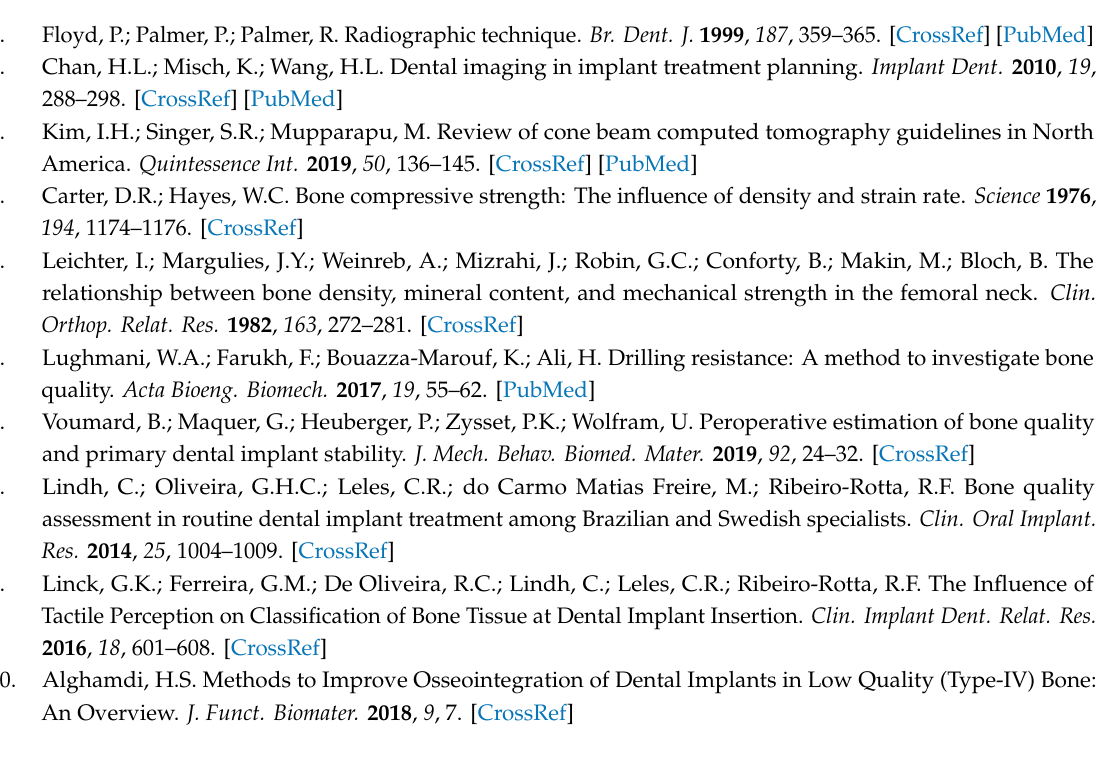
trabecular bovine tibia plateau sampling with the corresponding inclusion / exclusion criteria, Figure S3: Yucatan minipig sampling with the corresponding inclusion / exclusion criteria, Figure S4. Human data sampling with the corresponding inclusion / exclusion criteria. Table S1. Summary of in vitro bone surrogate material. Table S2. Summary of in-vitro bovine trabecular bone material. Table S3. Summary of in vivo minipig study material. Table S4. Summary of in vivo handling surveys’ material. Table S5: Mean ± Standard deviation for the maximum OS1 torques per length per density in bone surrogates. Table S6. Regression analysis of in vitro data: correlation between site preparation torque and density. Table S7. Mean ± Standard deviation for the maximum implantation torques per length per density in bone surrogates. Table S8. Regression analysis of in vitro data: correlation between implant insertion torque and site preparation torque. Table S9. Regression analysis of in vivo data: correlation between implant insertion torque and site preparation torque. Figure S5. Illustration of how mean ± SD obtained from all data in the shadowed area and 95% prediction intervals (PI) of implant insertion torque for a given OS1 torque ranges is